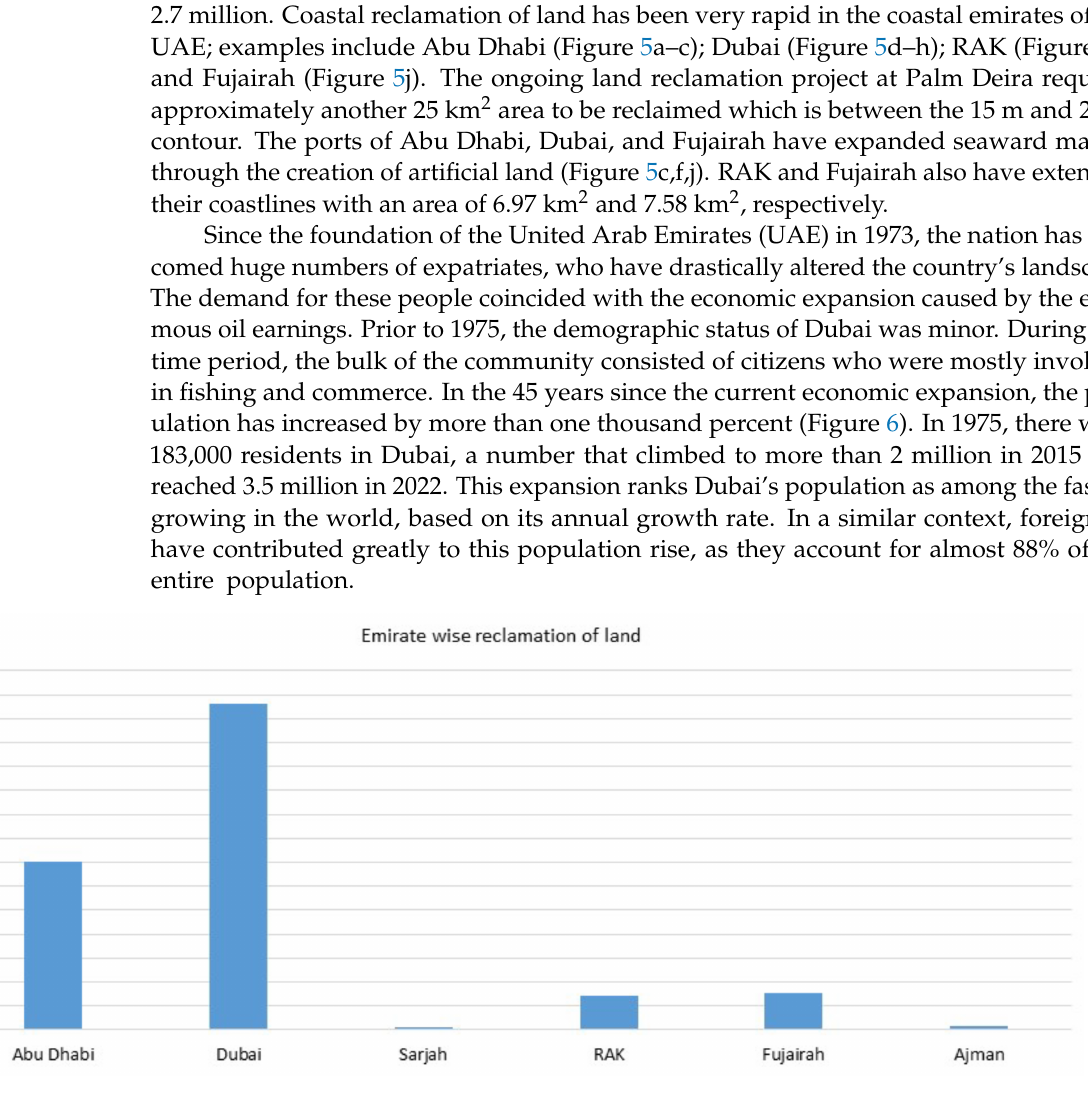
Figure 2. Bar graph representing the reclaimed area in each